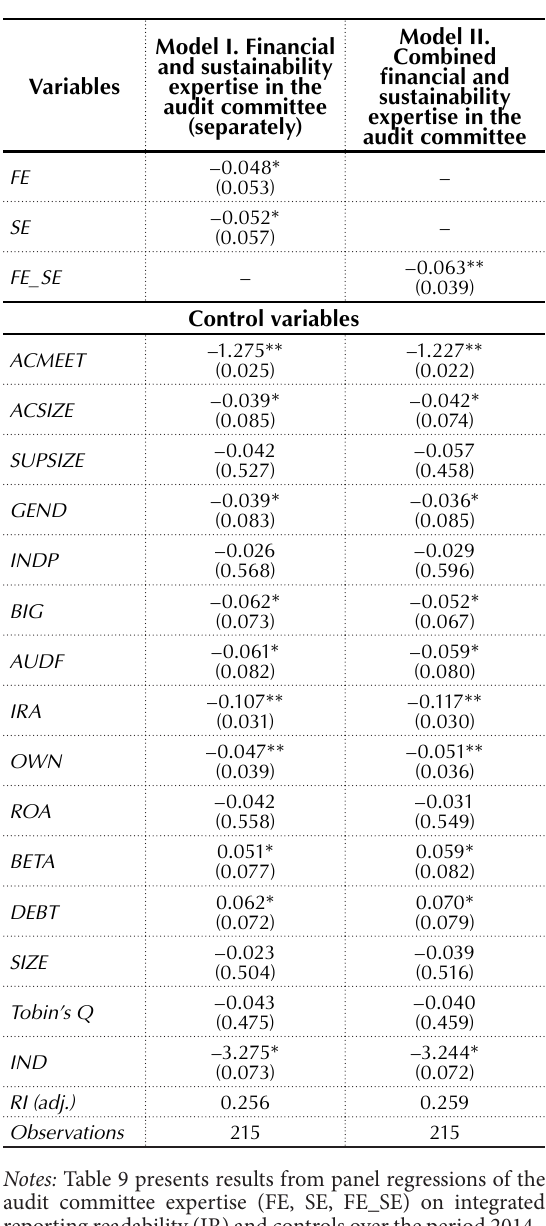
Table 9. Robustness checks (Fog